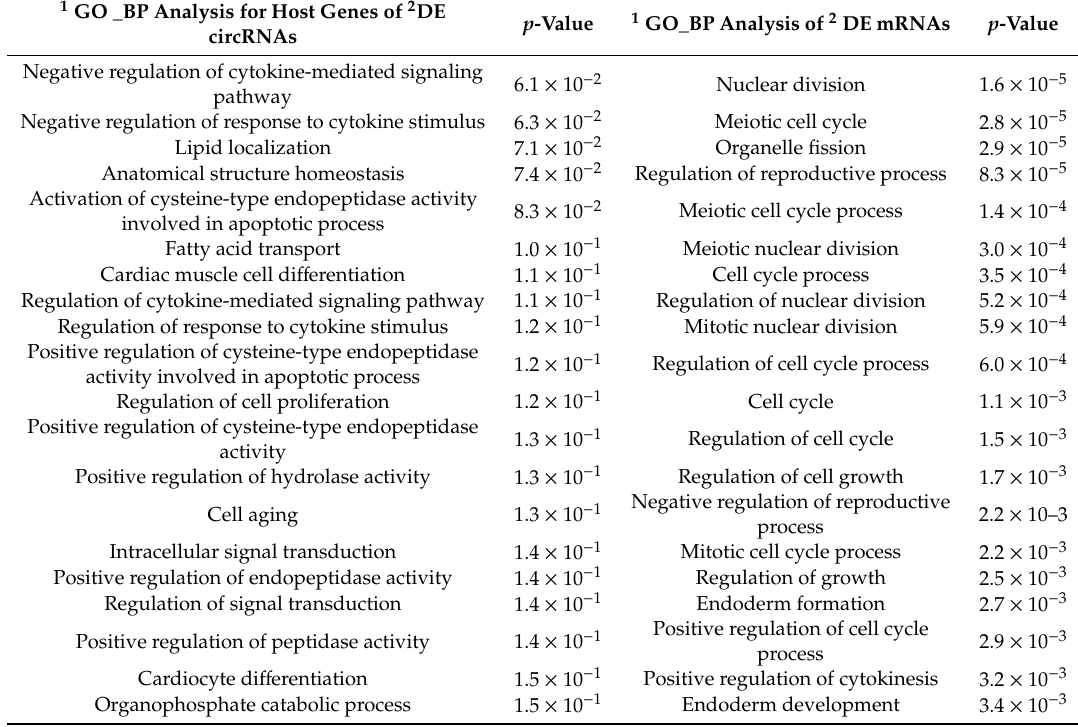
Table 1. Gene ontology (GO) analysis for all di ff erentially expressed transcripts in all groups.